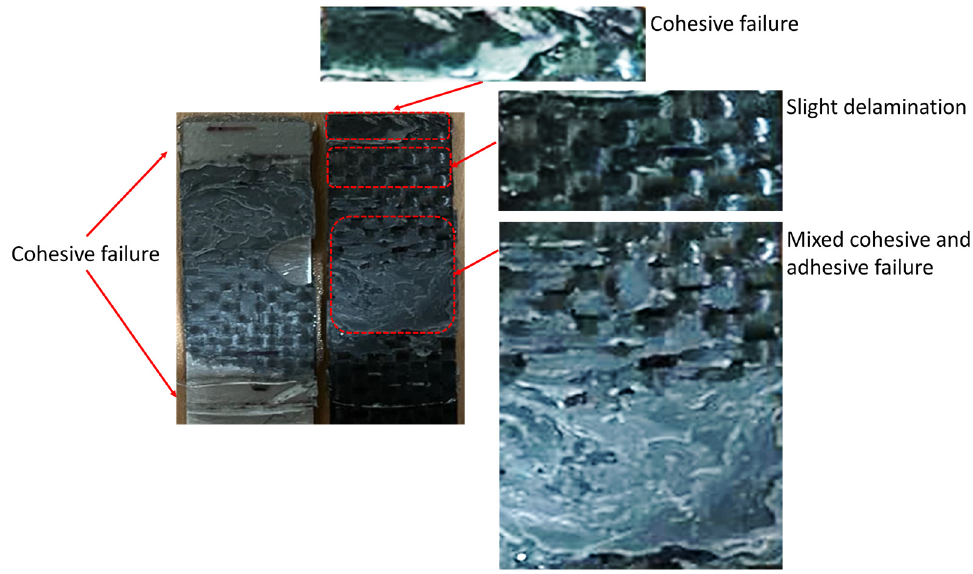
Figure 9. Schematic crack path and a typical fracture surface of the tested dissimilar SLJs.